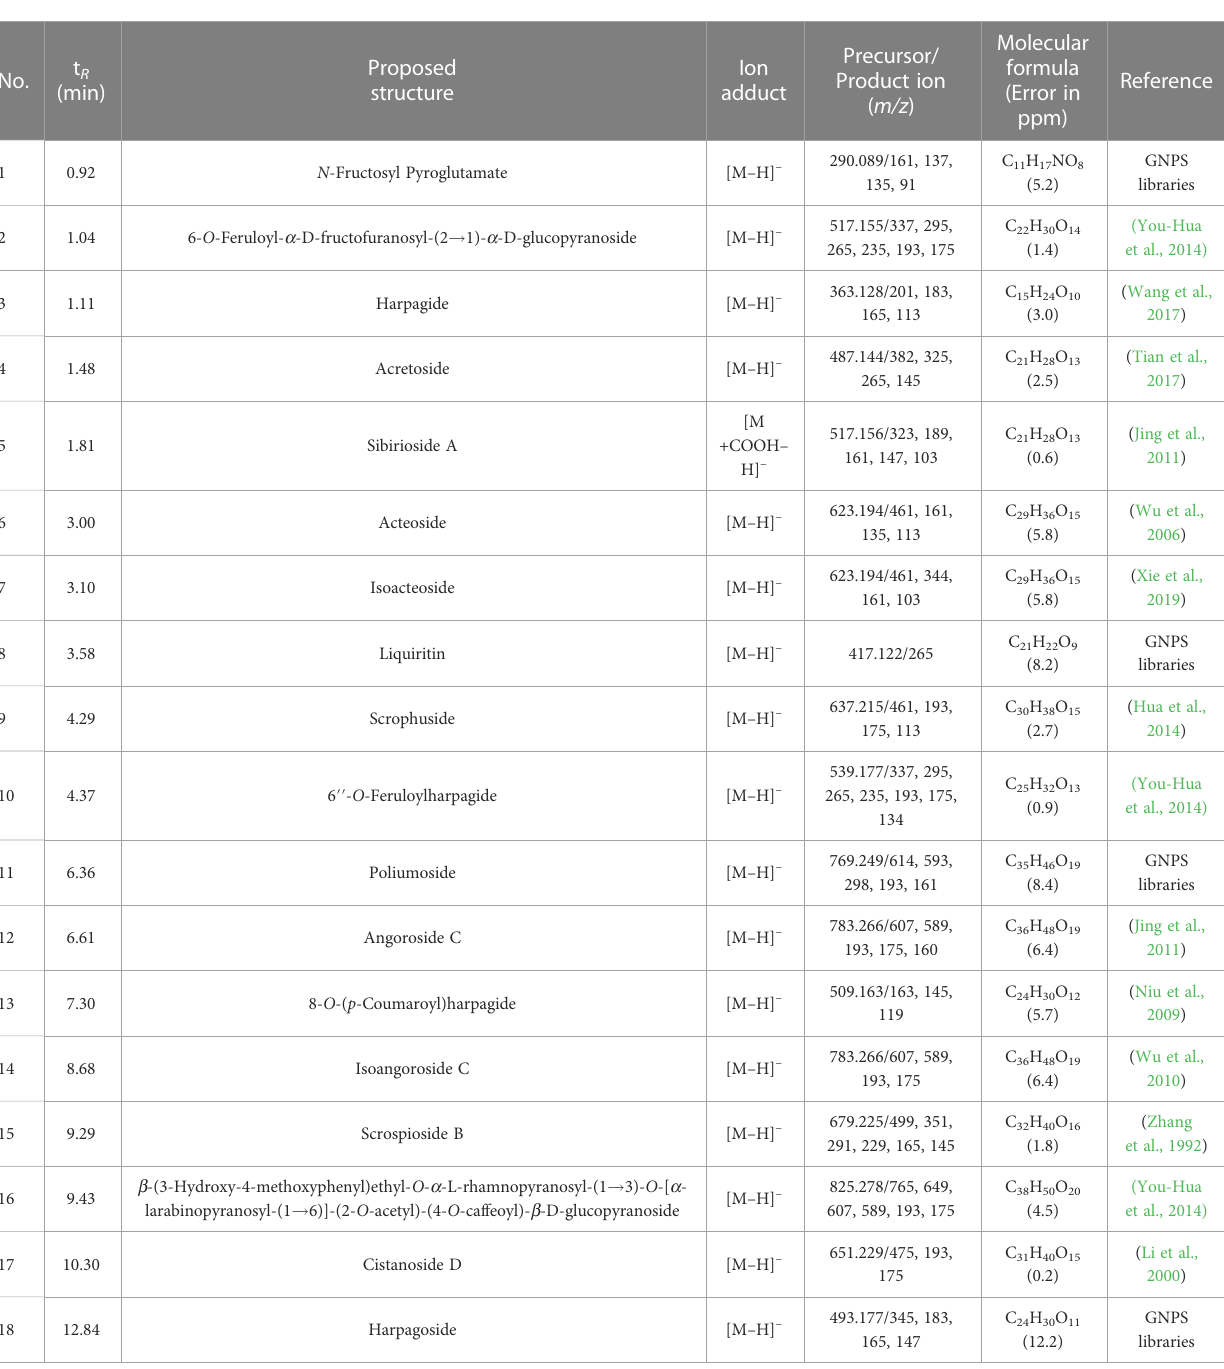
TABLE 1 Identi fi ed metabolites from the extract of Scrophularia ningpoensis Hemsl. No.